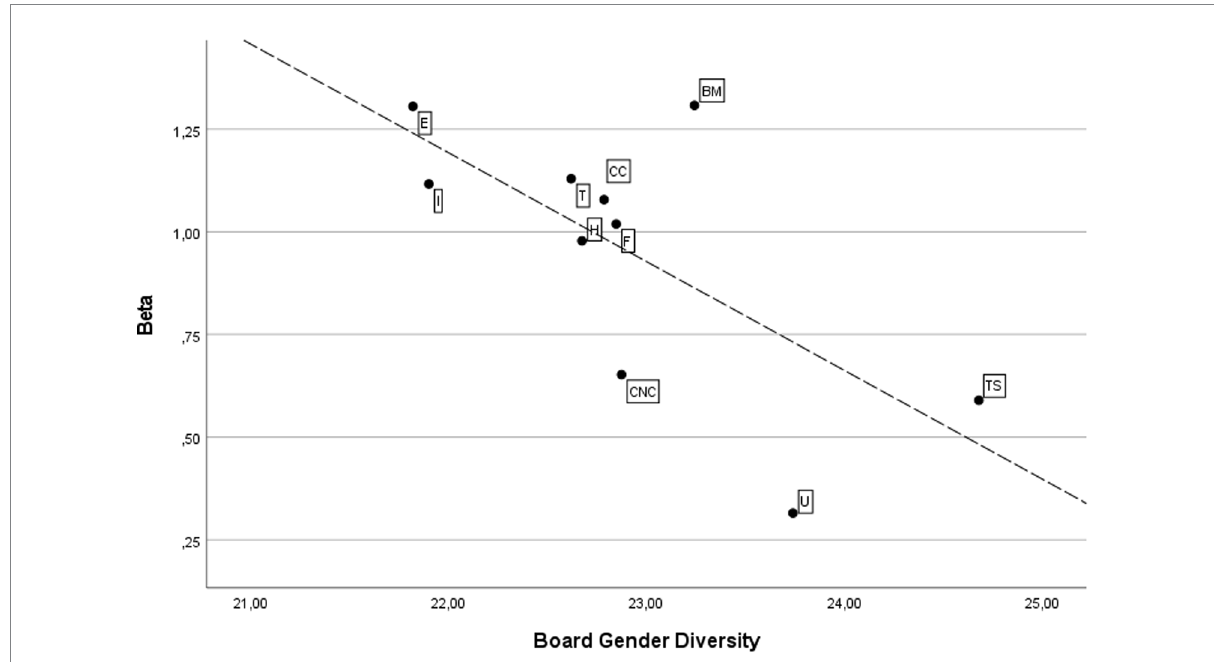
FIGURE 1 Scatter graph and fitted values by sectors in the U.S. market. B, Basic Materials; CC, Consumer Cyclicals; CNC, Consumer Non-Cyclicals; E, Energy; F, Financials; H, Healthcare; I, Industrials; T, Technology; TS, Telecommunication Services; U, Utilities.